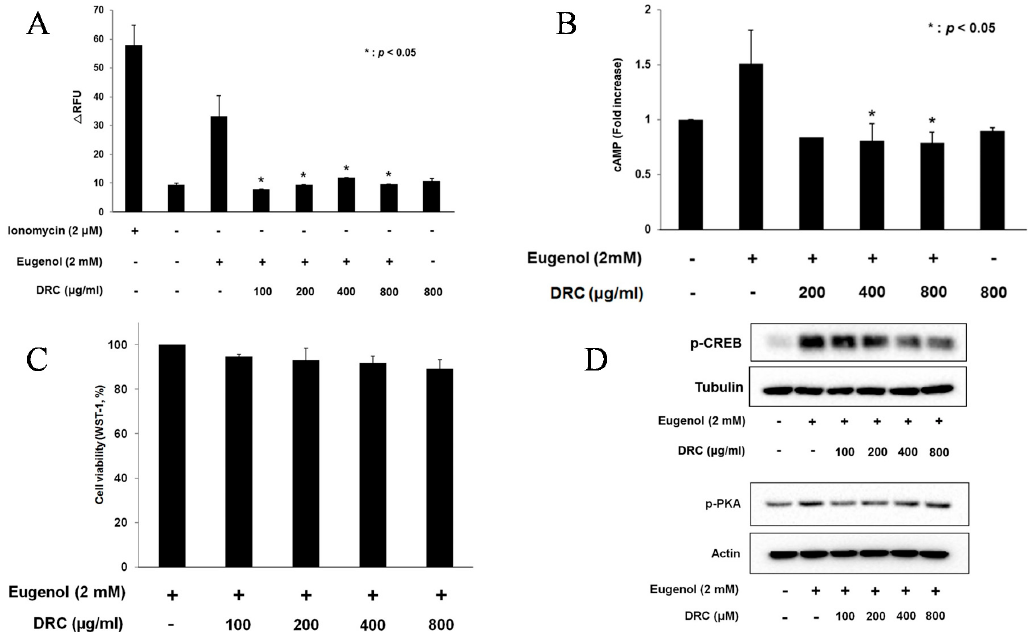
Figure 2. ( A ) The ethanol extracts of dictamni radicis cortex (DRC) decreased Ca 2+ levels in eugenol-induced 3T3-L1 cells. Ionomycin (2 μ M) and DMSO (0.2%) were used as positive and negative controls, respectively. Cells were treated with DRC extracts for 30 min, and Ca 2+ levels were measured after stimulation with eugenol (2 mM). The data are shown as means ± SD ( n = 3). *: p < 0.05, Δ RFU: change in relative fluorescence unit; ( B ) Changes in cAMP level after pretreatment with the ethanol extracts of dictamni radicis cortex (DRC) for 30 min. The high concentration of DMSO was 0.2% in this experiment. The data are shown as means ± SD ( n = 3). *: p < 0.05; ( C ) Cell viability. 3T3-L1 cells were treated with dictamni radicis cortex (DRC) extracts for 30 min. Cell proliferation was evaluated by WST-8 assay. The data are shown as means ± SD ( n = 3); ( D ) Phosphorylated protein kinase A (PKA) and cAMP response element binding protein (CREB) protein levels by Western blot in the 3T3-L1 cells after pretreatment with the ethanol extracts of dictamni radicis cortex (DRC) for 30 min. A total of 35 μ g of protein was separated by sodium dodecyl sulfate polyacrylamide gel electrophoresis (SDS-PAGE).